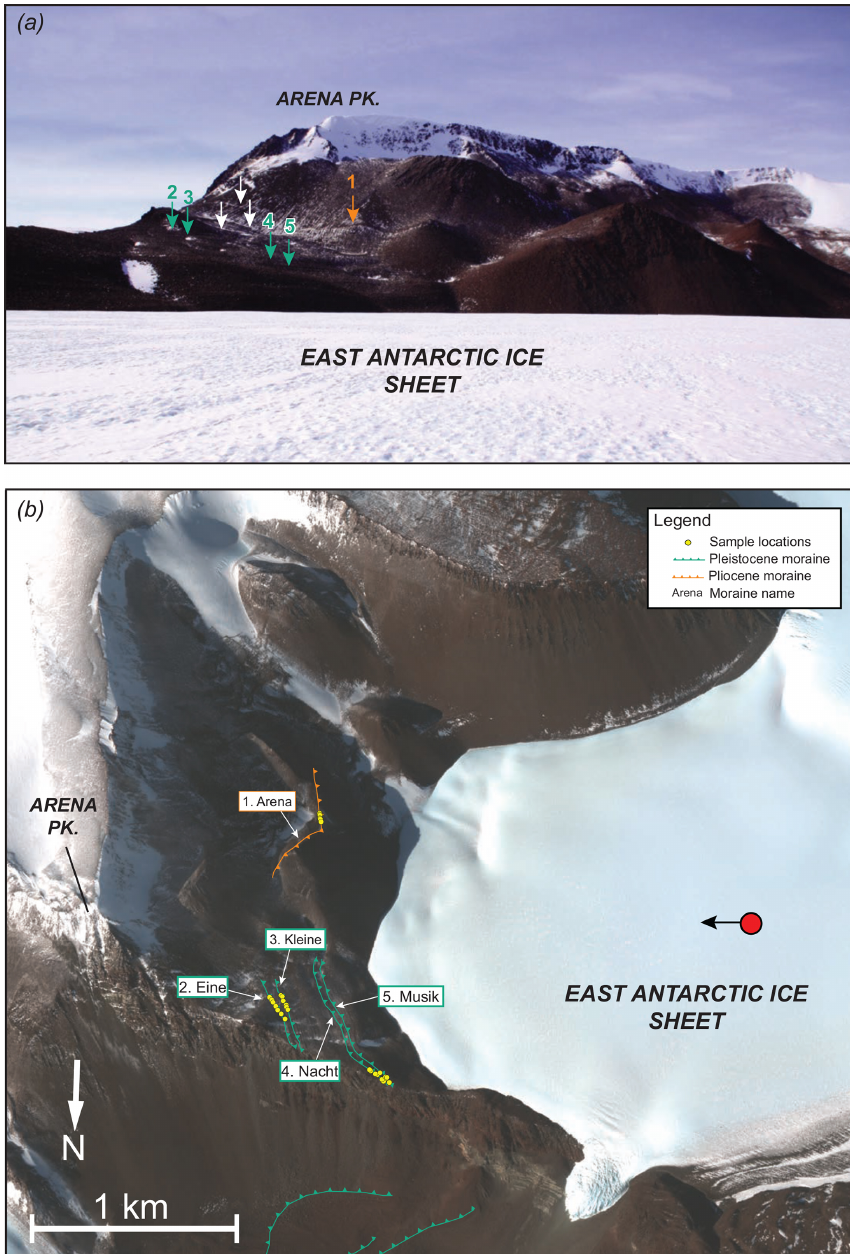
Figure 7. Upper Roberts Massif. (a) Photograph of the Upper Roberts transect with moraines marked by arrows, numbered corresponding to sampled moraines in (b) . White arrows in (a) denote undated moraines. (b) Geomorphic map of Upper Roberts. The red circle and arrow shows the location and vantage of photo in (a) . The base map in (b) is derived from WorldView-2 satellite imagery (© 2017, DigitalGlobe,